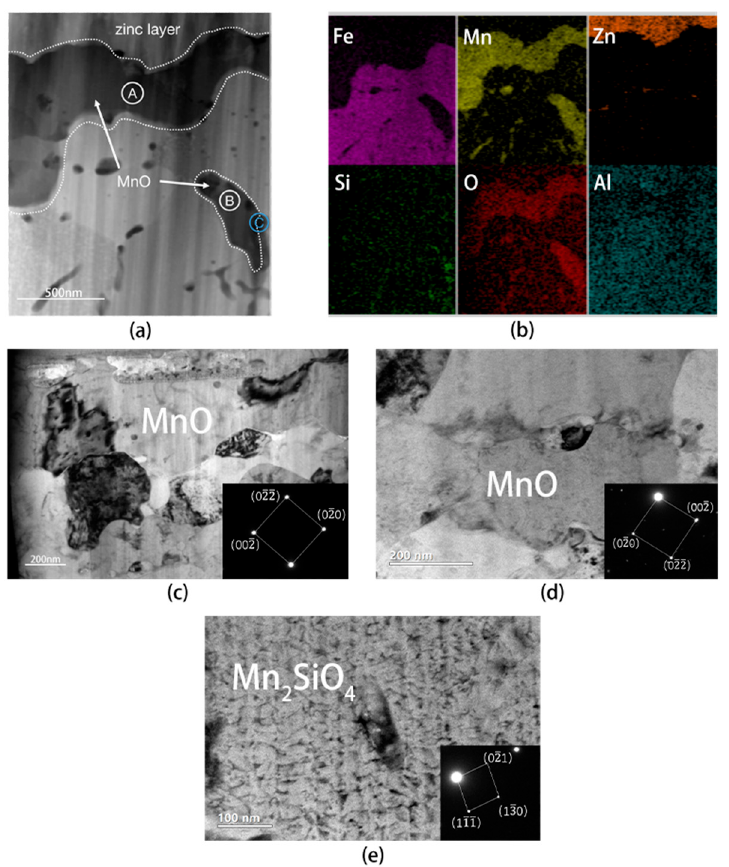
Figure 14. ( a ) TEM analysis of the Zn coating / Fe substrate interface of the galvanized sample 6#. ( b ) cross-sectional elemental maps of the area shown in ( a ). ( c ) Bright filed image and di ff raction pattern of the oxide particle corresponding to zone A in ( a ). ( d ) Bright filed image and di ff raction pattern of the oxide particle corresponding to zone B in ( a ). ( e ) Bright filed image and di ff raction pattern of the oxide particle corresponding to zone C in ( a ).